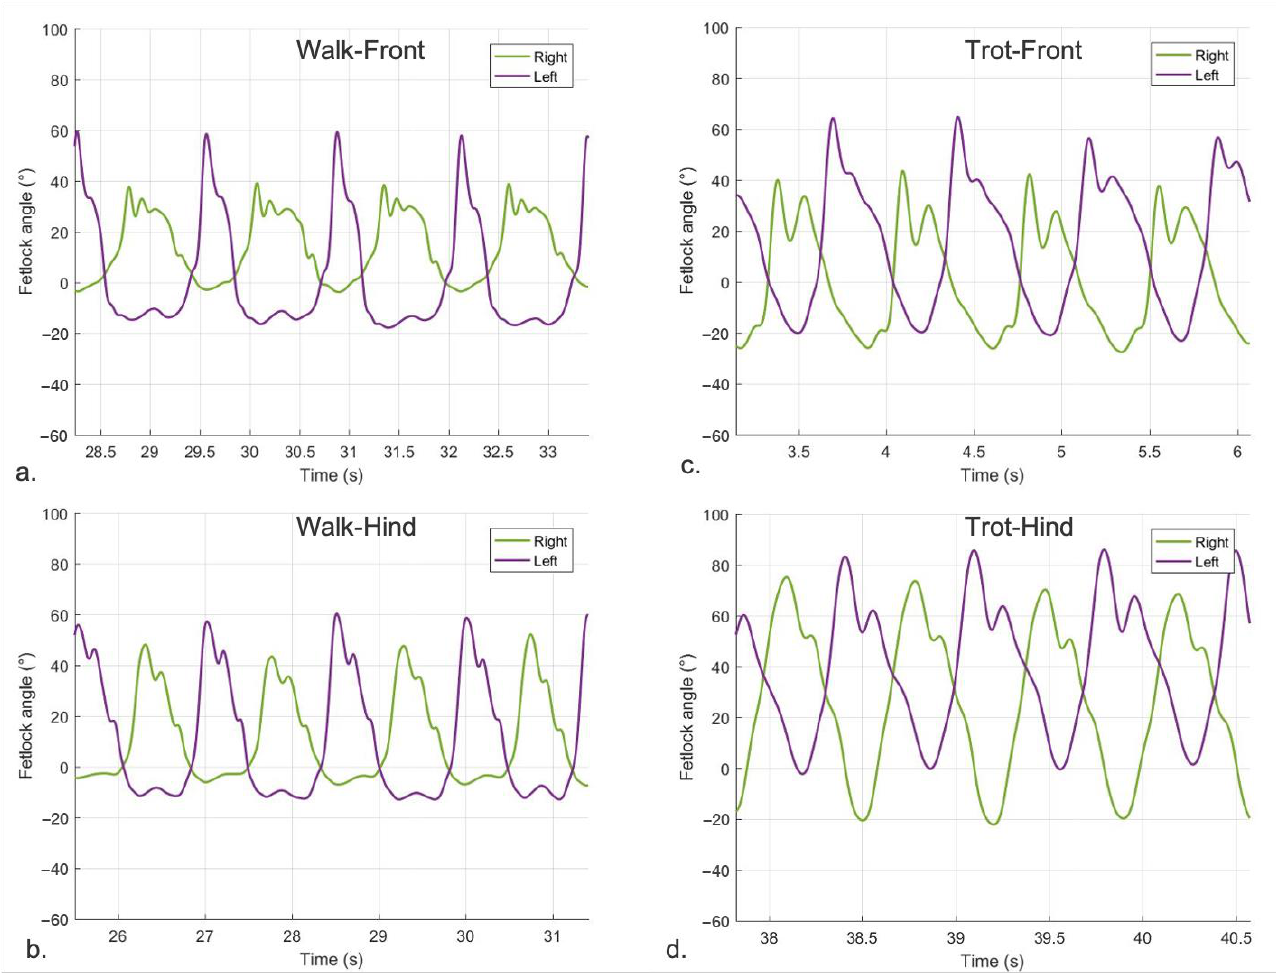
Figure 5. Panels show fetlock joint angle pattern quantified by the MOVIT IMU system in the lame limb and its contra-lateral over time in 4 different horses. Positive values of angles (°) represent flexion and negative values extension of the fetlock joint; ( a ) horse z01-right front lame (green-mean 44.22°) and left front contralateral (violet-mean 75.60°) at the walk; ( b ) horse z05-right hind lame (green-mean 52.88°) and left hind contralateral (violet-mean 70.38°) at walk; ( c ) horse z08-right front lame (green-mean 87.98°) and left front contralateral (violet-mean 98.69°) at trot; ( d ) horse z06-left hind lame (violet-mean 73.35°) and right hind contralateral (green-mean ROM 94.34°) at trot. In sound horses, the mean FJROM value in front limbs captured by the MOVIT IMU system was 57.79° ± 4.50° at walk and 82.83° ± 6.64° at trot. The mean FJROM in hind- limbs at walk was 60.48° ± 6.10°, and 89.40° ± 4.89° at trot. The FJROM coefficient of vari- ation (CV) between pairs of front limbs (left vs. right) was 3% at the walk and 2.51% at the trot. The CV between paired hind limbs (left vs. right) was 3.91% at the walk and 3.60% at the trot. The mean degree of difference in FJROM between paired front limbs was 1.76° at walk and 0.57° at trot, and between hind limbs was 0.86° at walk and 1.58° at trot. In lame horses, the CV of FJROM between the lame limb and the contralateral was 15.47% at the walk and 7.06% at the trot. The mean degree of difference in the FJROM between the lame limb and contralateral was 19.84° in lame at the walk and 8.44° when considering all lame horses at two gaits. The normalized stride fraction of the FJA in sound and lame limbs of the horses present in the study are illustrated in Figure 6 (walk) and Figure 7 (trot).